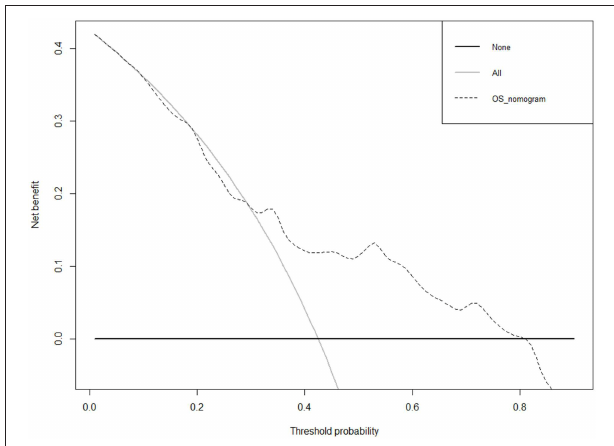
FIGURE 7 | The result of decision curve analysis of the 21-miRNA